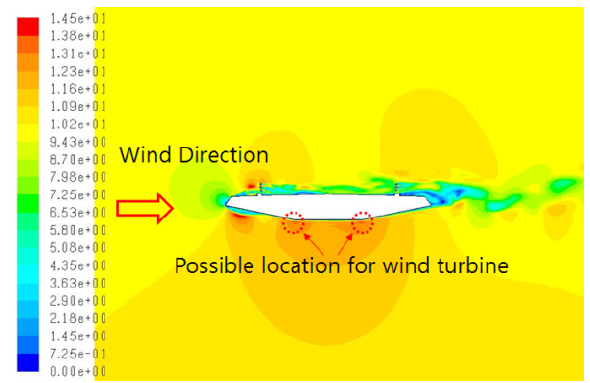
Figure 4. CFD analysis result and possible installation